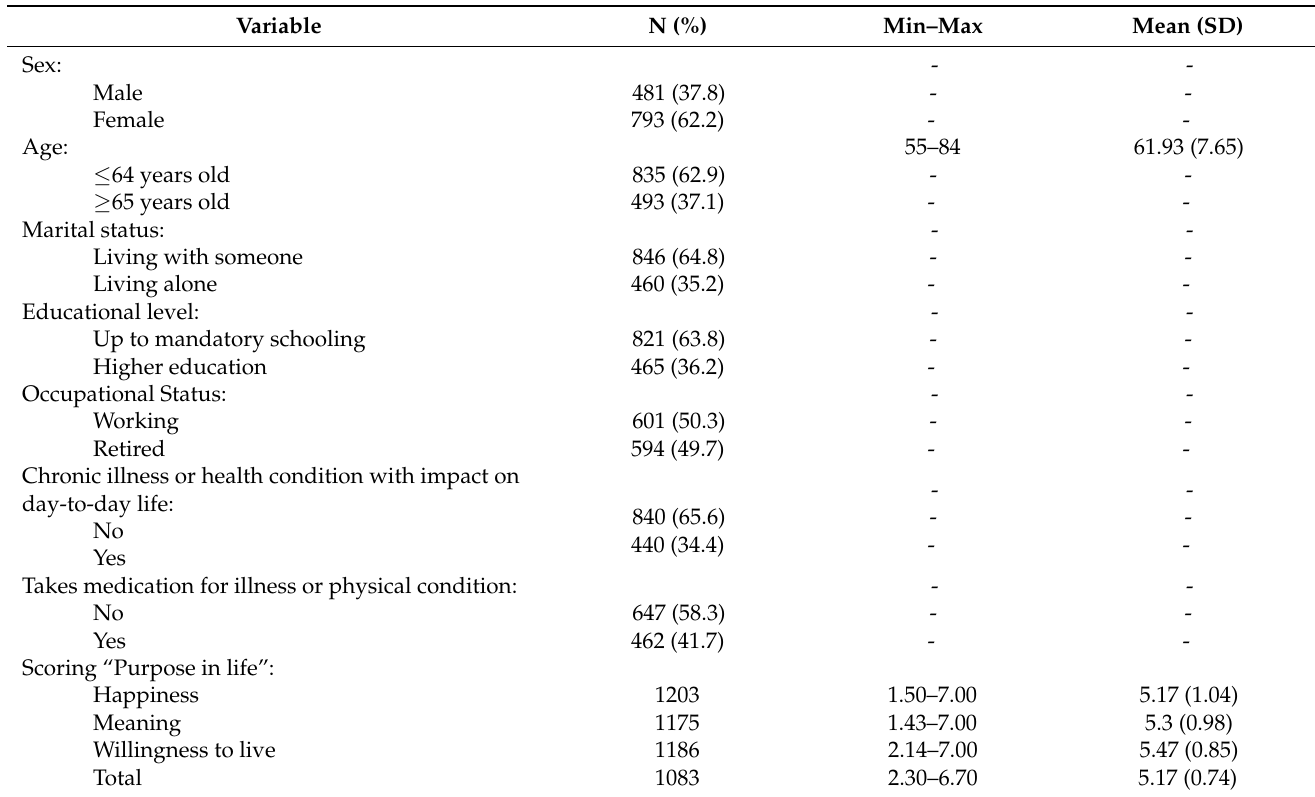
Table 1. Sample sociodemographic and general characteristics (descriptive